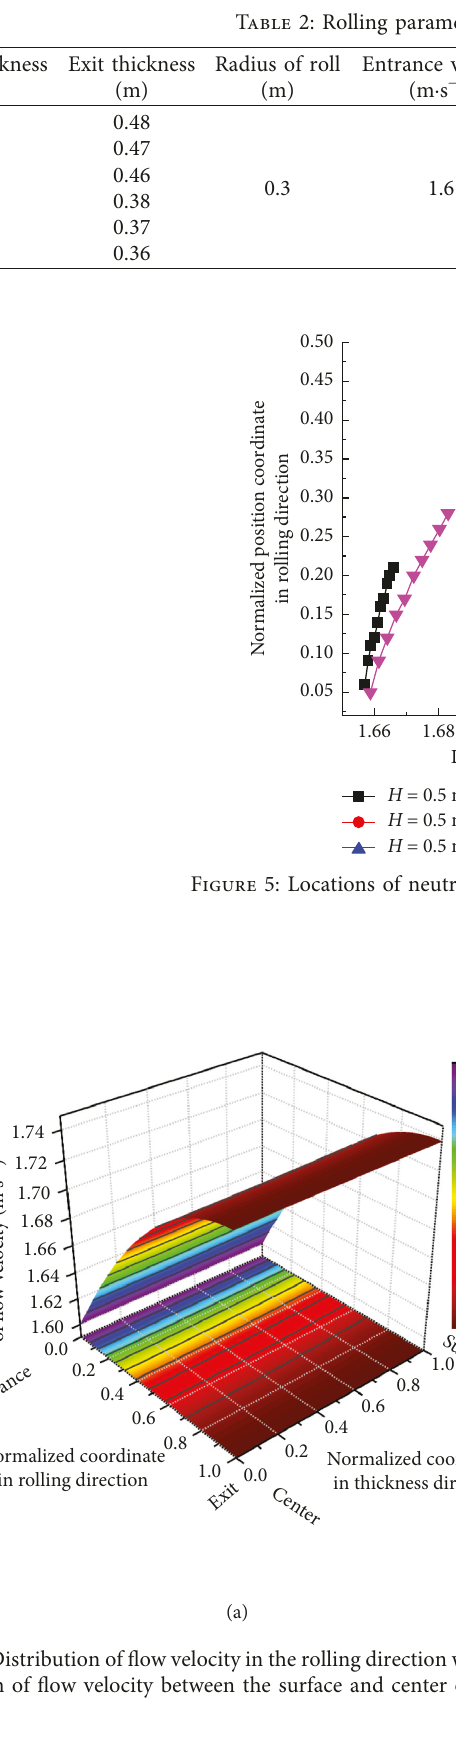
� 1 . 6m/s: (a) 3D contour and (b) 0